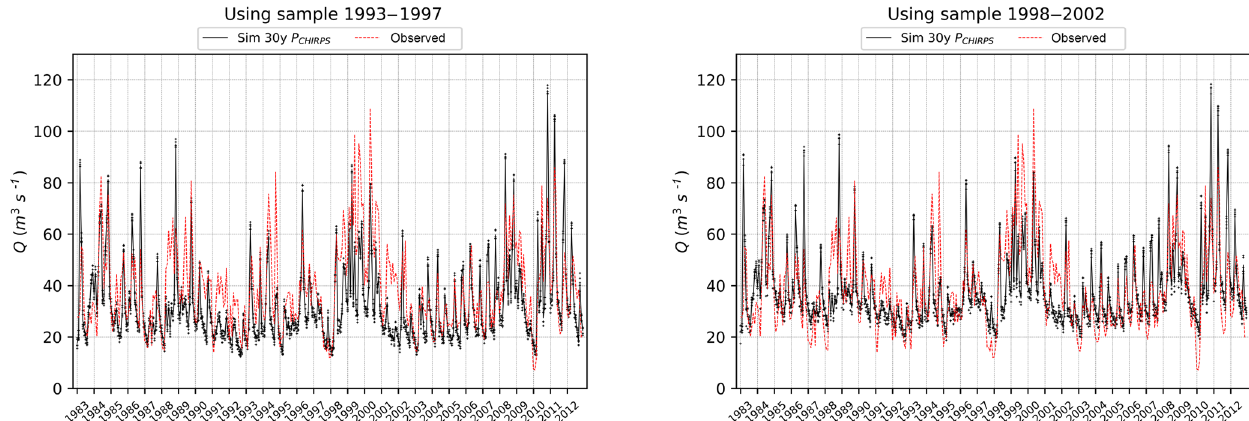
Figure 5. Observed and simulated discharge for the Coello River at Payende with 30 years (1983–2012) of CHIRPS precipitation (Sim 30yr P CHIRPS ) for calibration samples 1993–1997 and 1998–2002, with the sample used to calibrate the model indicated in the